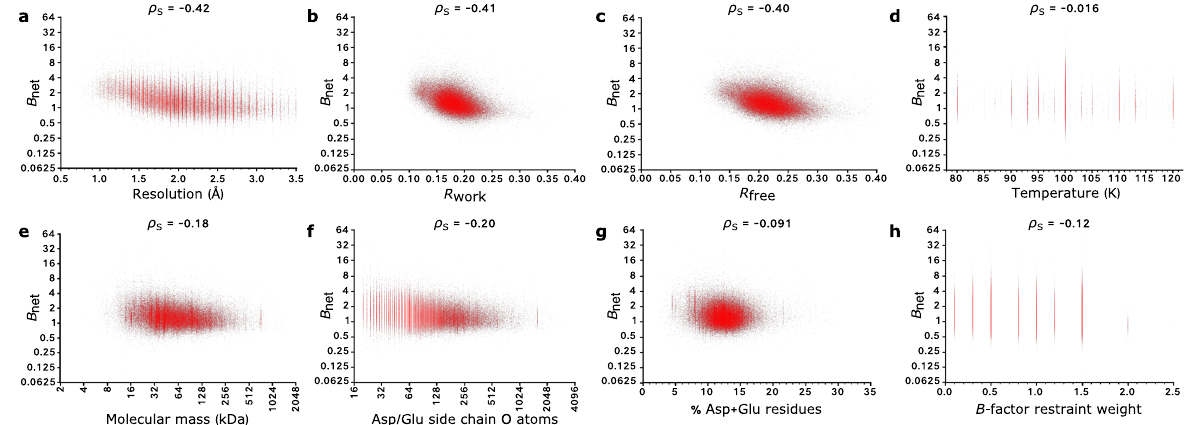
Fig. 4 Investigating the dependence of B net on various parameters. Scatter plots of B net vs.: a resolution; b R work ; c R free ; d temperature; e molecular mass; f the number of aspartate/glutamate side-chain oxygen atoms; g the percentage of aspartate/glutamate residues; and h the strength of B -factor restraints applied in the fi nal round of re fi nement. The Spearman ’ s rank correlation coef fi cient ( ρ S ) between the two variables is reported for each plot. Source data are provided at